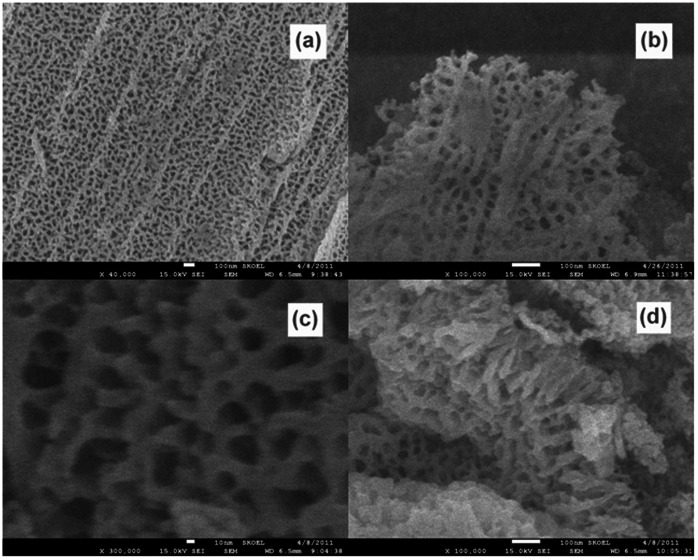
SEM images of the CLTO films formed in the electrolyte of EG +10%H2O +0.25%H3PO4+3%NH4F.(a) top view; (b) a fragment (c) the magnification of (a); (d) cross-sectional view.